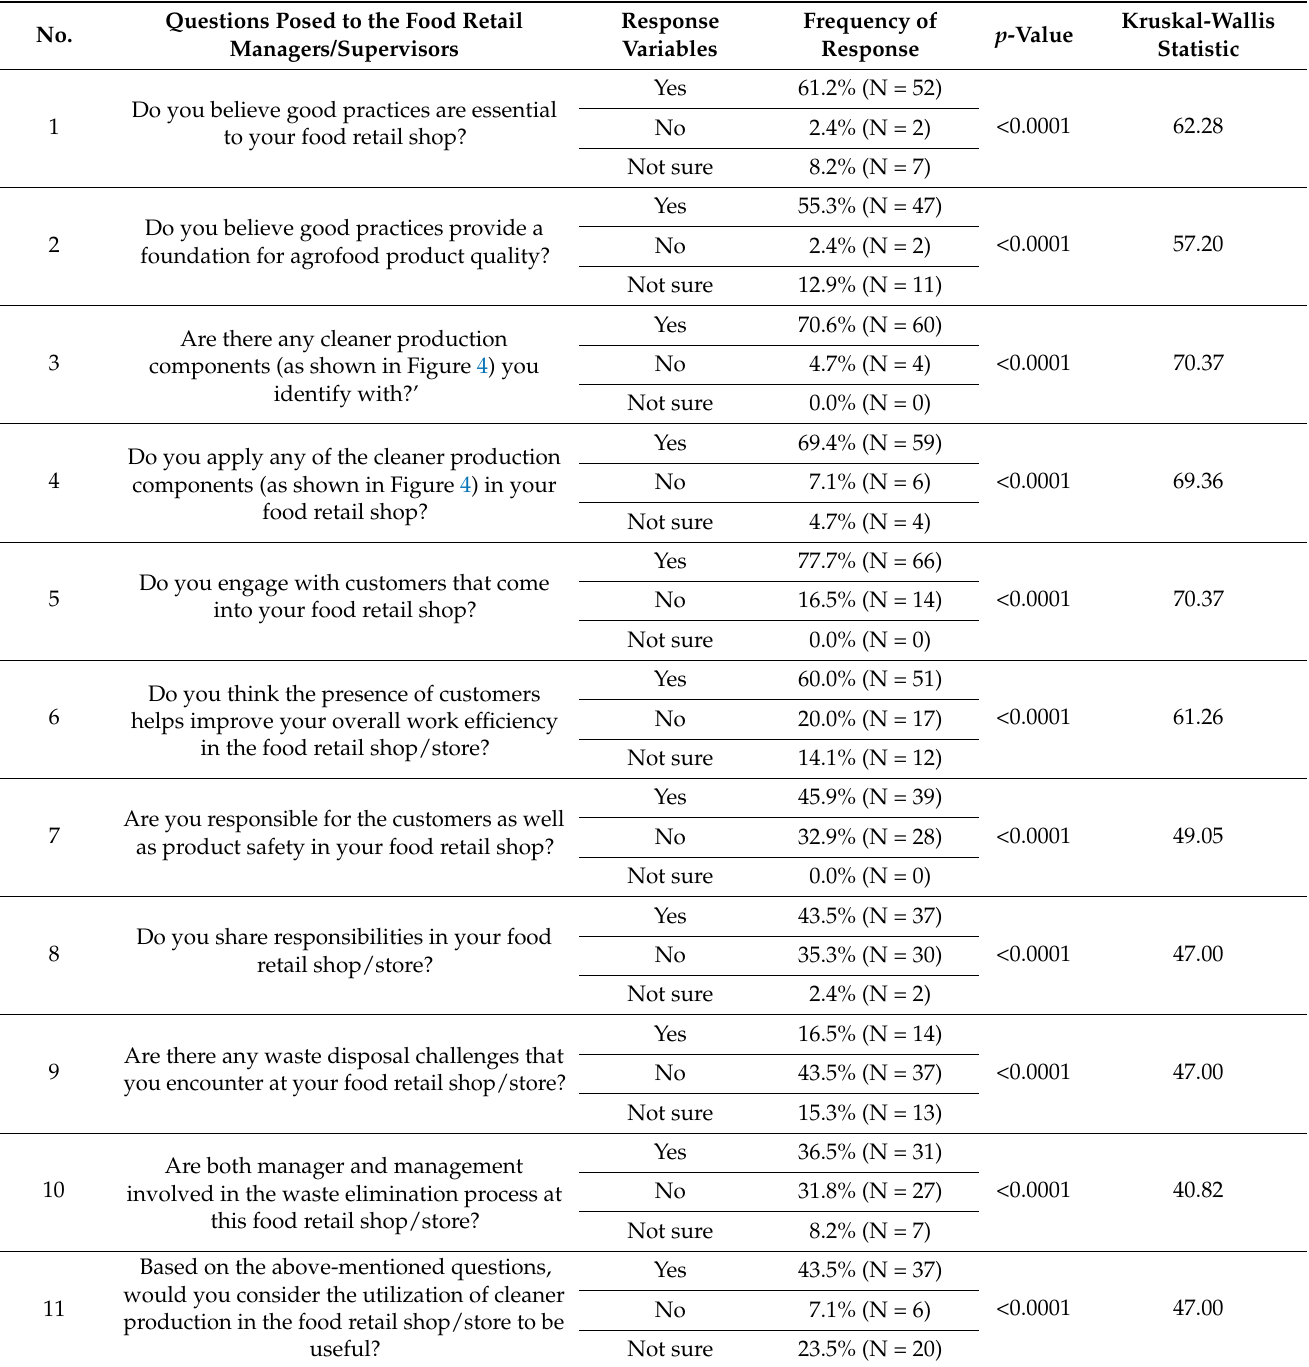
Table 2. Managers’/ supervisors’ responses to questions about the extent at which their good practices would contribute to achieving cleaner food production in their respective (food) retail